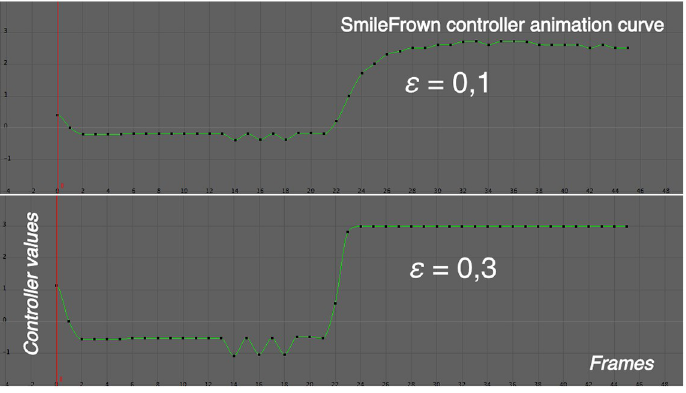
Fig 4. Animation curve for the SmileFrown controller at different ε